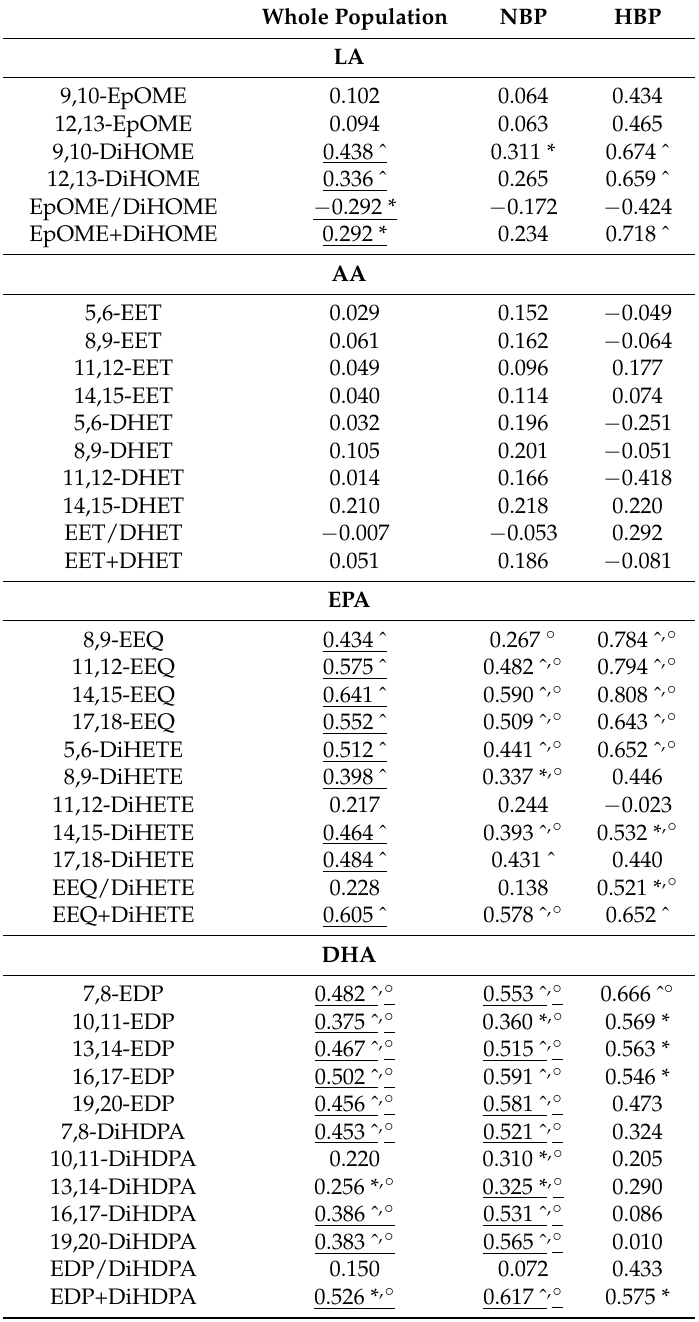
Table 2. Correlations between fatty acids (precursors) and the derived eicosanoids via CYP450-